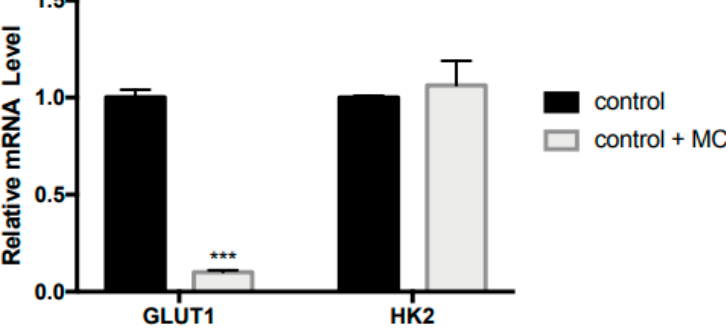
Figure 4. MC treatment reduced GLUT1 gene expression in macrophages in the absence of LPS-induced inflammation. Group comparison was performed using the Student’s t -test (*** p < 0.001).